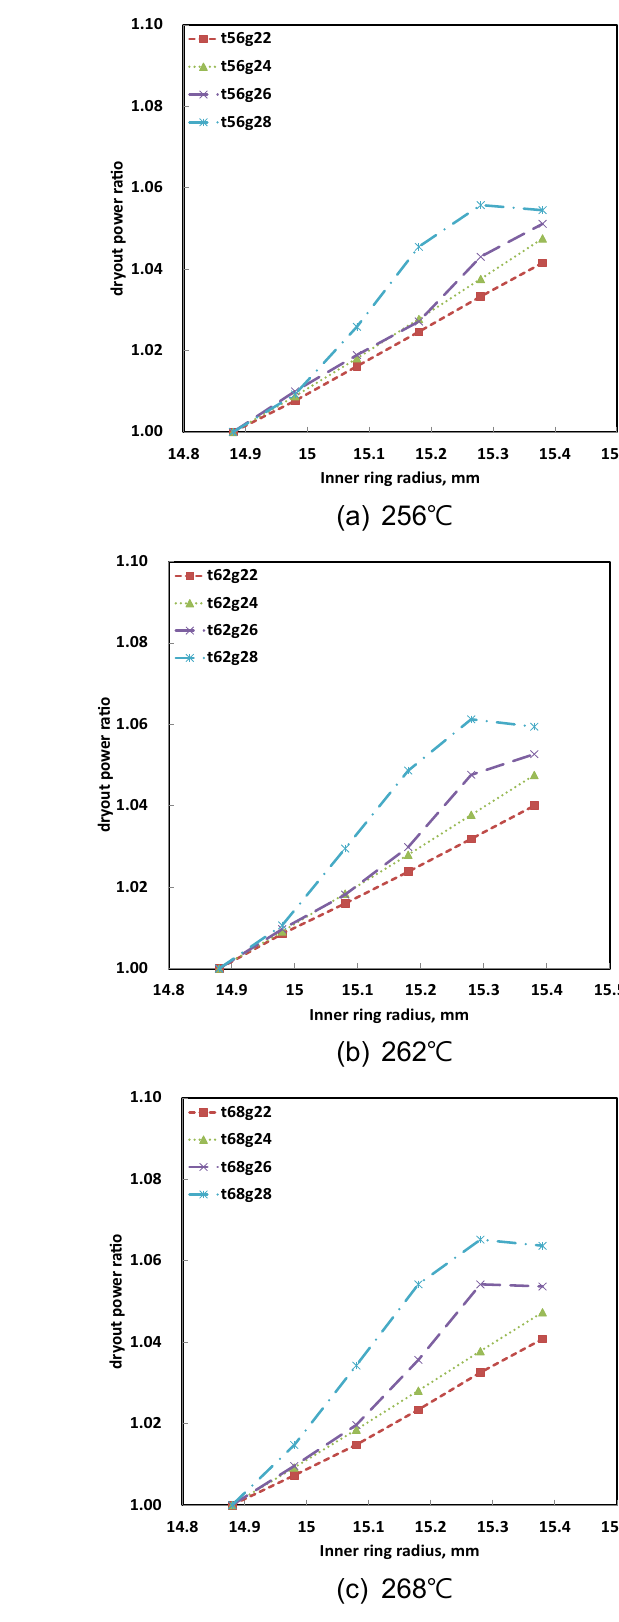
Fig. 10. Dryout power ratio of a 37A fuel bundle for 3.3% crept pressure tube.